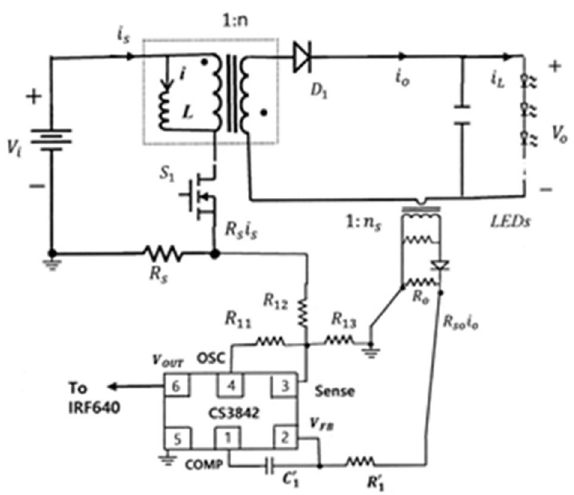
Figure 8. Experimental prototype circuit of CMC flyback LED driver with stabilization